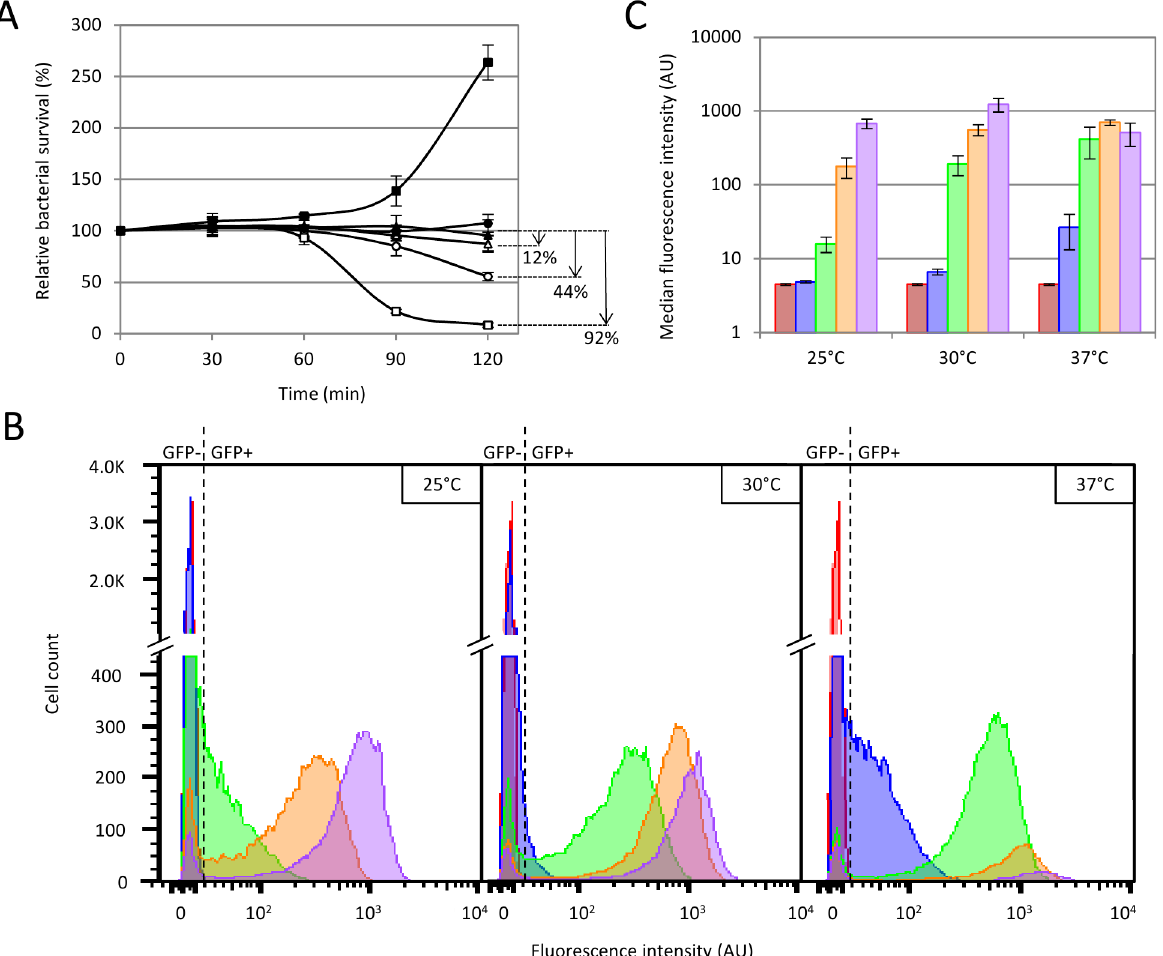
Fig 2. Determination of optimal detection conditions. (A) Bacterial survival analyzed by flow cytometry as a function of time under several temperature conditions. Bacterial cell counts were measured immediately after infection then each 30 min for 2 hours. E . coli TD2158 was either non infected (dark symbols) or infected with HK620::P rrnB - gfp phage (white symbols). Cultures were incubated at 25°C (triangles), 30°C (circles), or 37°C (squares). The relative bacterial survival is the ratio between the bacterial cell count at 30 min, 60 min, 90 min, or 120 min and the initial bacterial cell count multiplied by 100. Arrows show the percentage of lysed bacteria 2 hours post-infection. (B) and (C) Fluorescence intensity obtained with phagosensors under several temperature conditions. E . coli TD2158 was infected with HK620::P rrnB - gfp phage and incubated at 25°C, 30°C or 37°C. Fluorescence intensities were monitored immediately after infection (red) then 30 min (blue), 60 min (green), 90 min (orange) and 120 min (purple) post-infection. (B) Cytometry histograms represent the number of fluorescent or non-fluorescent cells gated to the bacterial population as a function of the fluorescence intensity. Panels from left to right correspond to results obtained at 25°C, 30°C and 37°C, respectively. The dotted line represents the limit between negative fluorescence (GFP-) and positive fluorescence (GFP+) determined by using the fluorescent negative control WT HK620. (C) Column histograms represent the means of median fluorescence intensities obtained with a triplicate of sample incubated at 25°C, 30°C or 37°C.